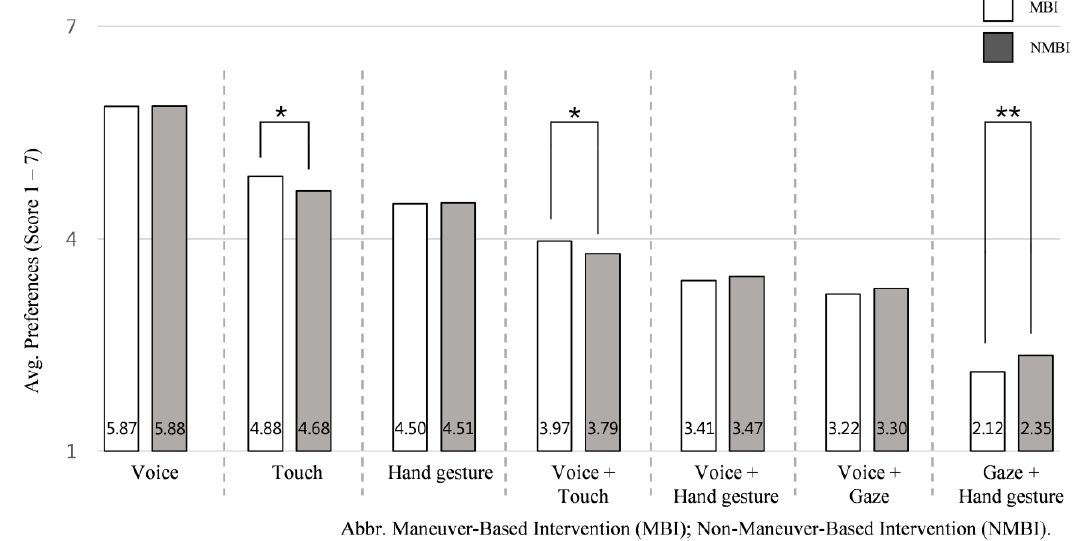
Figure 11. Average preference for the seven input interactions according to the intervention scenarios: maneuver-based intervention (MBI) vs. nonmaneuver-based intervention (NMBI).